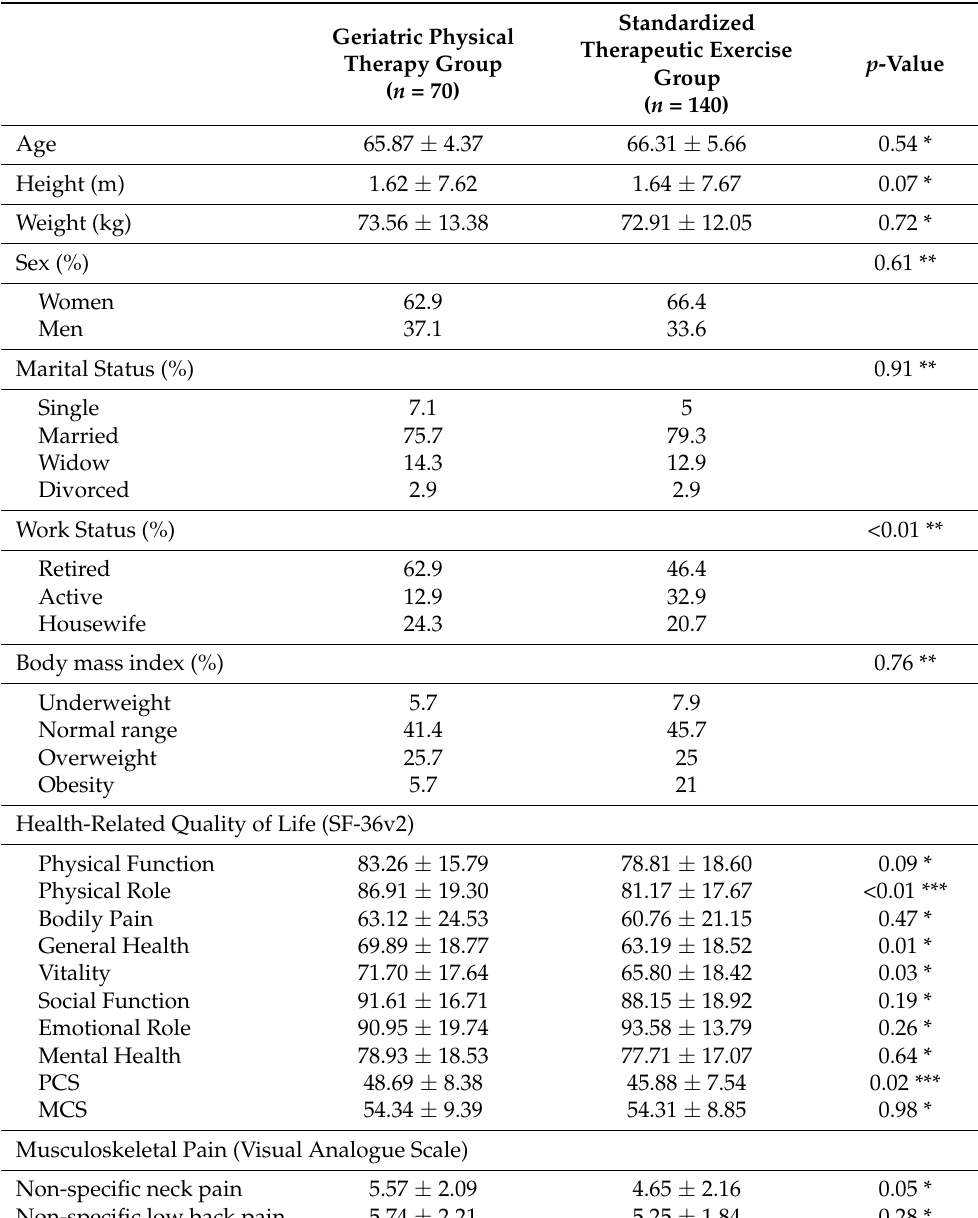
Table 3. Descriptive characteristics of the sample according to the intervention groups at baseline (A 0